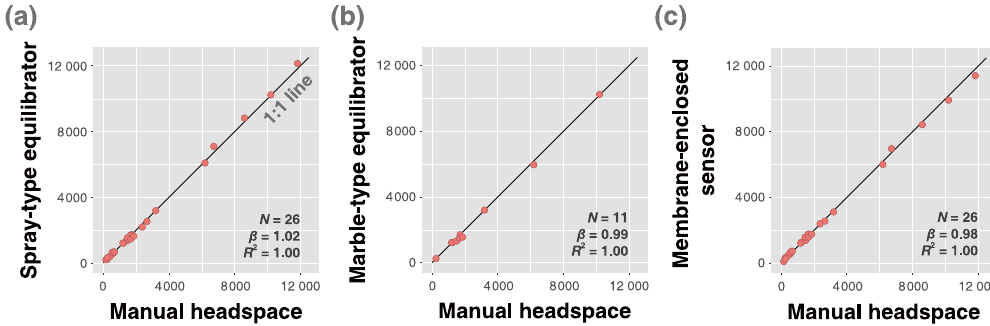
Figure 3. Comparison of p CO 2 (µatm) measurements of three gas equilibration systems (spray- and marble-type equilibrators and membrane-enclosed sensor) with the manual headspace equilibration at various inland waters, ranging from forested headwater streams to the estuary of the Han River.